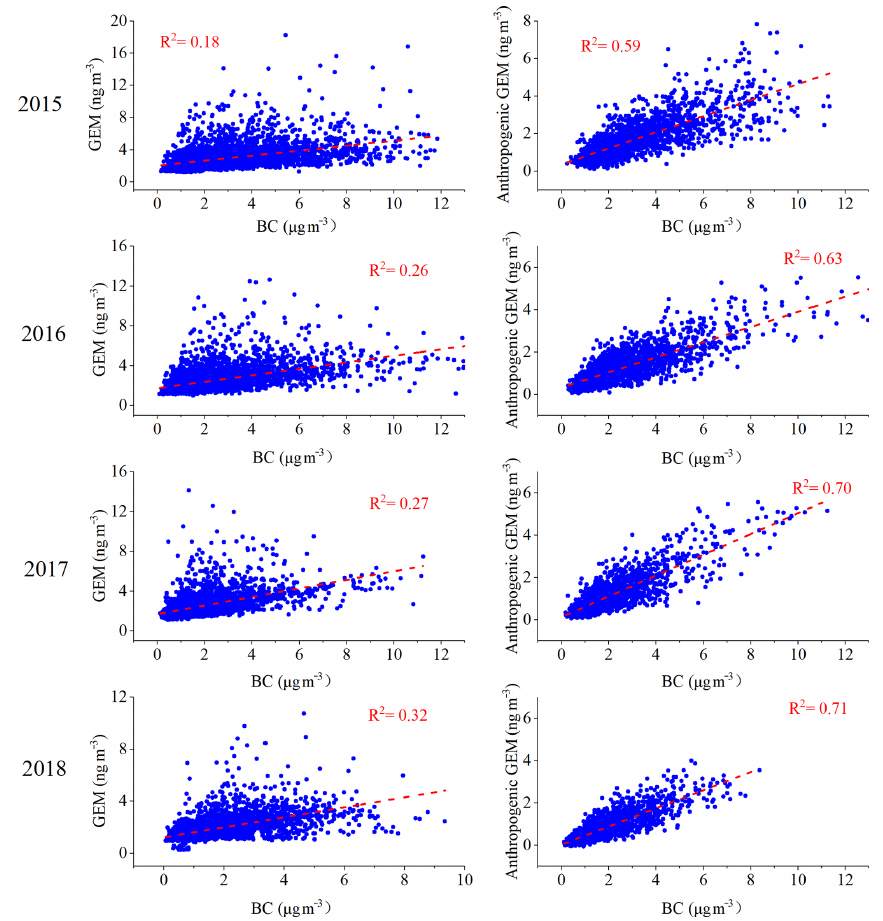
Figure 5. The relationship between observed GEM and BC and anthropogenic GEM (extracted from PMF results) and BC during